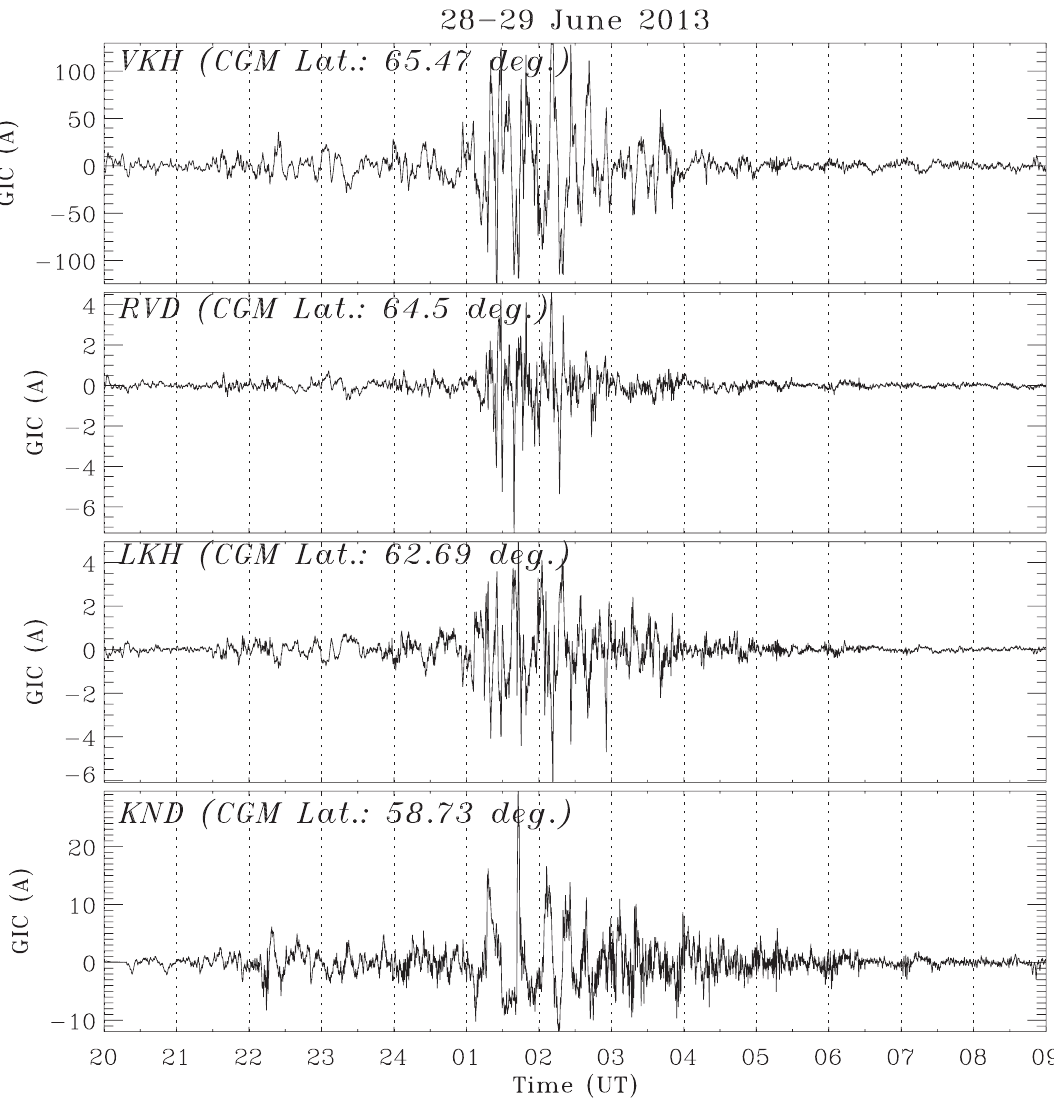
Fig. 12. GIC [A] at stations VKH, RVD, LKH, and KND (1-min data) between 20 UT on 28 June and 09 UT on 29 June, 2013. Corrected geomagnetic latitudes are shown near station